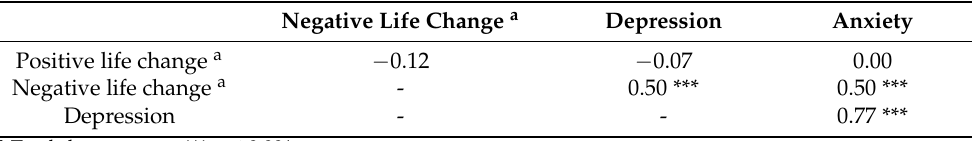
Table 6. Intercorrelations of positive and negative life changes, depression, and anxiety ( N = 164). Negative Life Change a